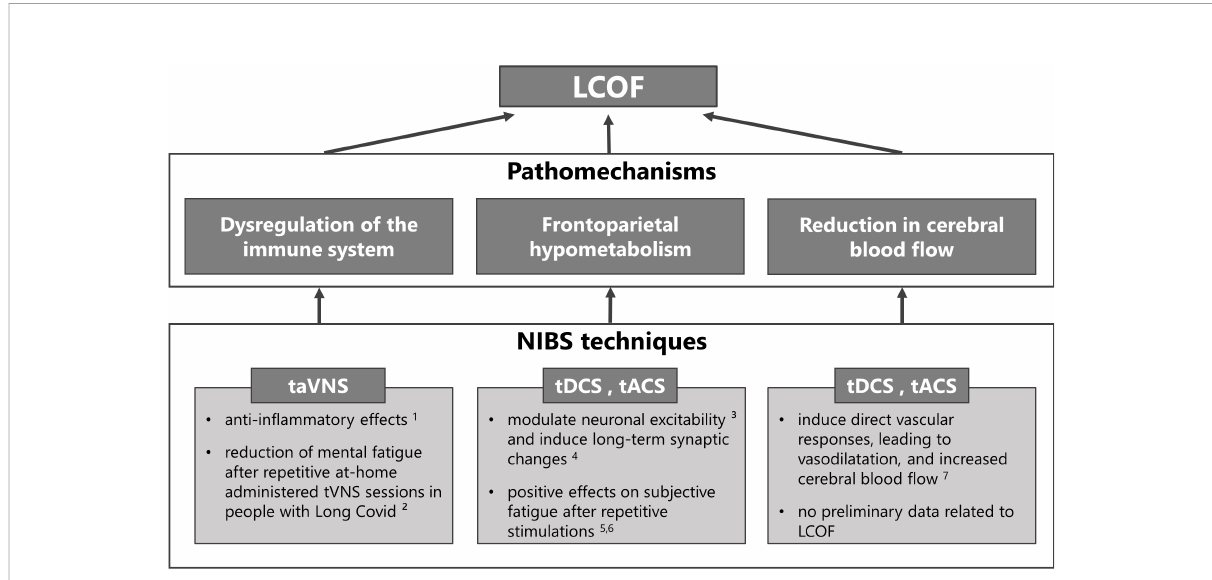
FIGURE 1 Non-invasive brain stimulation (NIBS) techniques for the treatment of individual pathomechanisms of Long-COVID-related fatigue